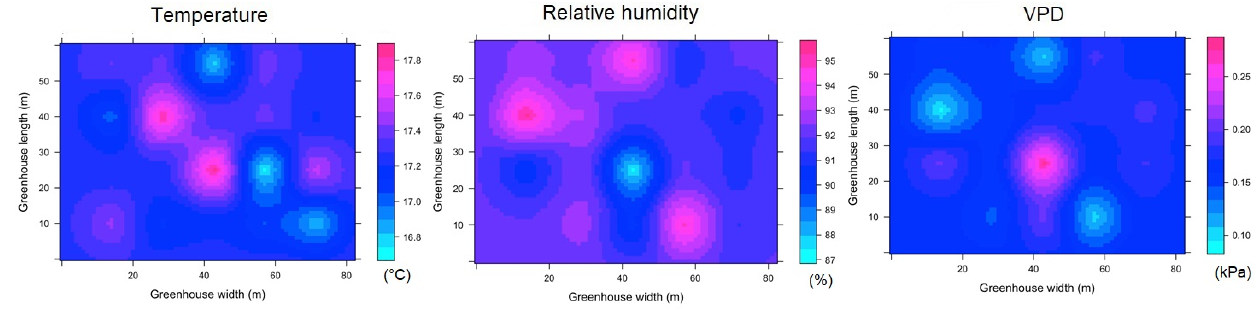
Figure A14. Spatial distribution predicted by kriging, for temperature, relative humidity and VPD in HGT2 and for ESRL 3.